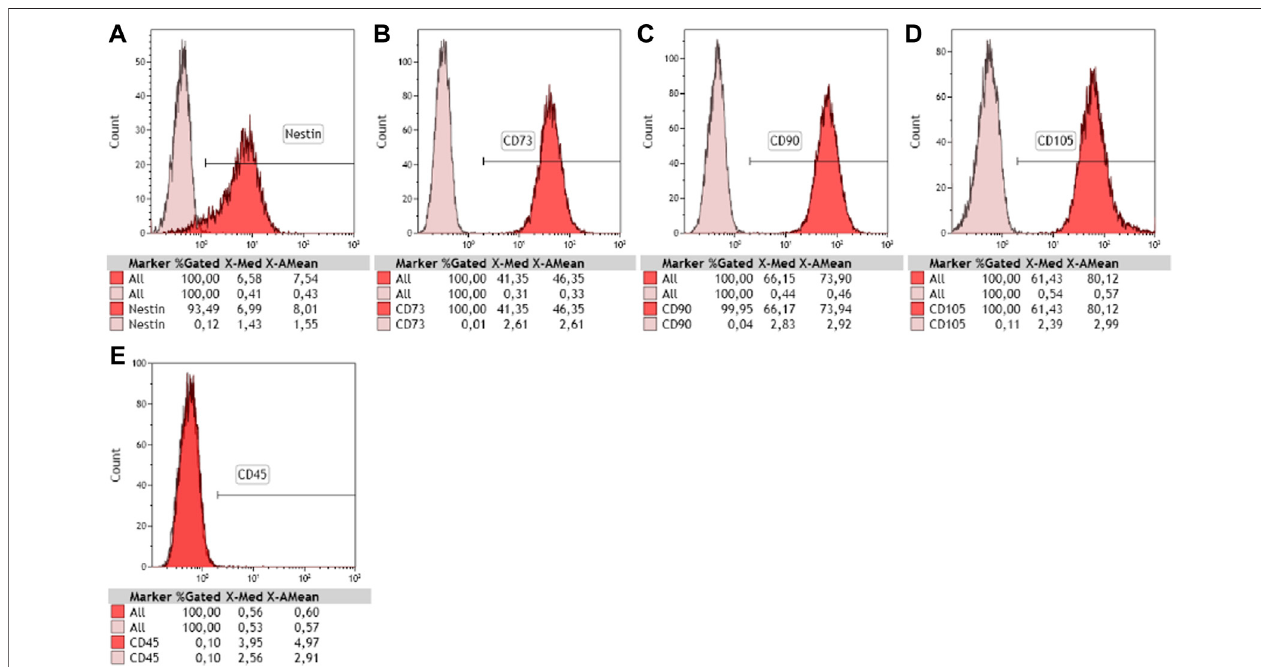
FIGURE 1 | Characterization of newborn nasal stem cells. Phenotyping of cultivated cells was performed using fl ow cytometry and stem cell-speci fi c markers. Puri fi ed nasal ecto-mesenchymal stem cells (NE-MSCs) were positive for nestin (A) , CD73 (B) , CD90 (C) , and CD105 (D) , recognized markers of mesenchymal stem cells, and negative for CD45 (E) , known marker for hematopoietic stem cells. 10,000 events counted.